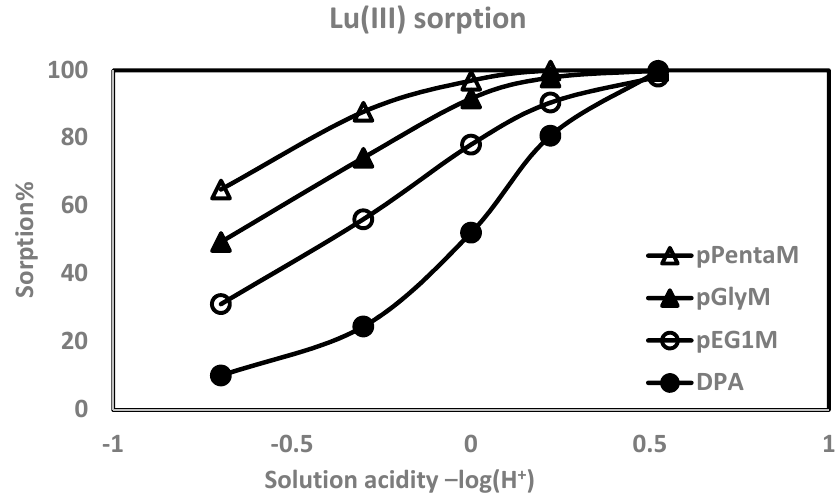
Figure 5. Metal ion affinities among the polymers: pPentaM > pGlyM > pEG1M > DPA.